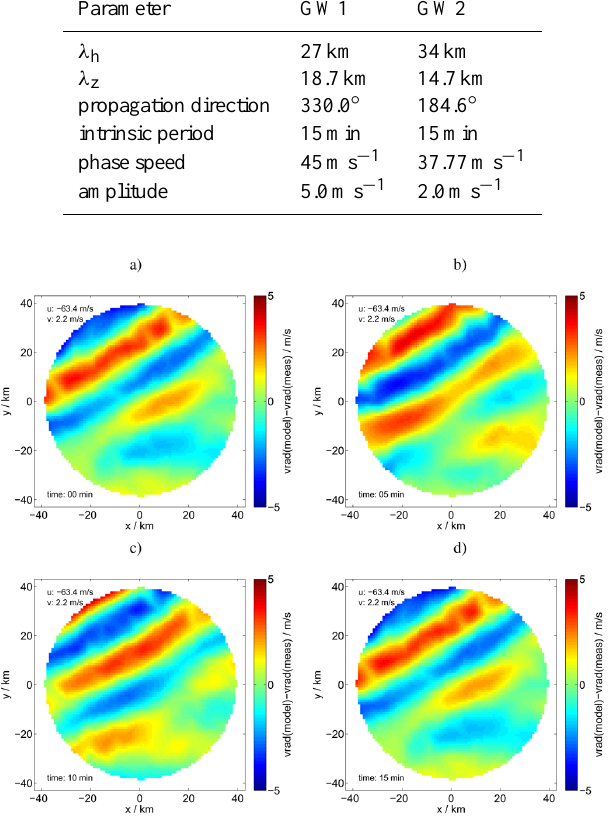
Fig. 10. Simulation of radial velocity variation images computed using a superposition of two GW. The temporal evolution of the field of view is shown in (a) – (d) . The temporal resolution is